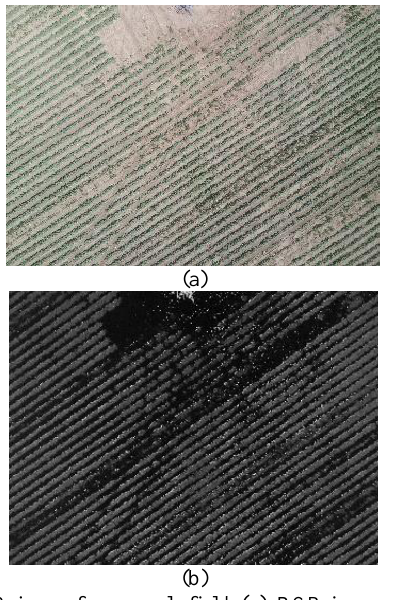
Figure 2. image for a canola field. (a): RGB image, (b): Hue image.